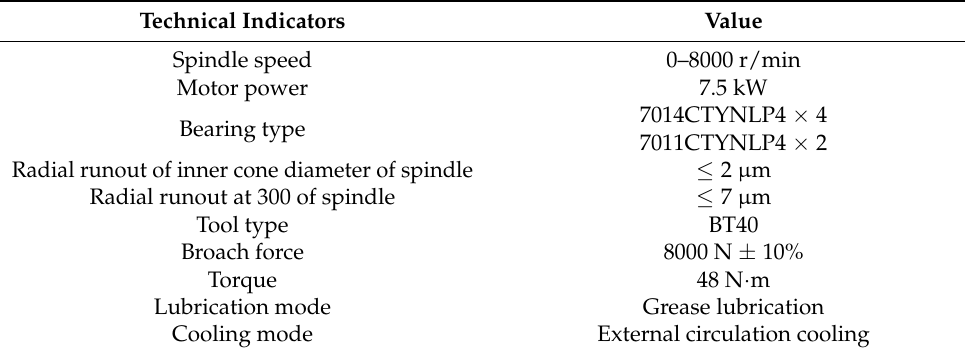
Table 3. The technical indicators of the tested motorized spindle.